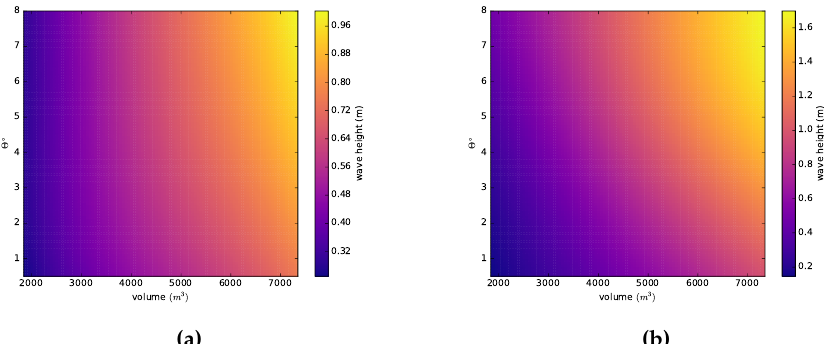
Figure 8. Sobol’ indices calculated from run-up, approximated using Equation (7). The input parameters as shown along the x axis are: submergence depth, D ( m ) ; viscosity, µ ( Pas ) ; yield stress, τ ( Pa ) ; shear thinning exponent, N ; density, ρ ( kgm − 3 ) ; slope angle, θ ◦ , boundary layer parameter; µ ( kgm − 2 s − 1 ) ; volume, V ( m − 3 ) ; inundated slope angle, β ◦ ; and maximum offshore water depth, l d ( m ) .